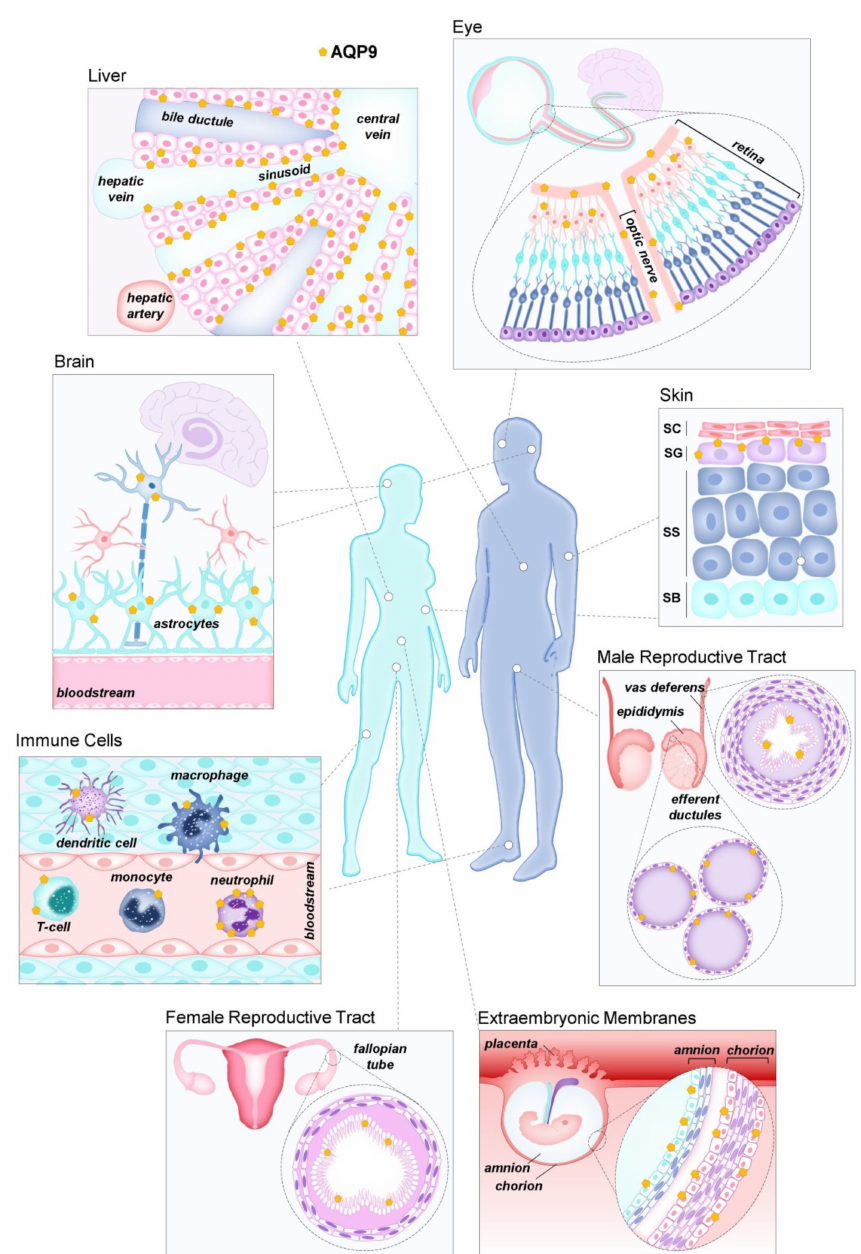
Figure 2. Aquaporin-9 (AQP9) distribution in human tissues. These tissues were reported to express AQP9, although several locations still need